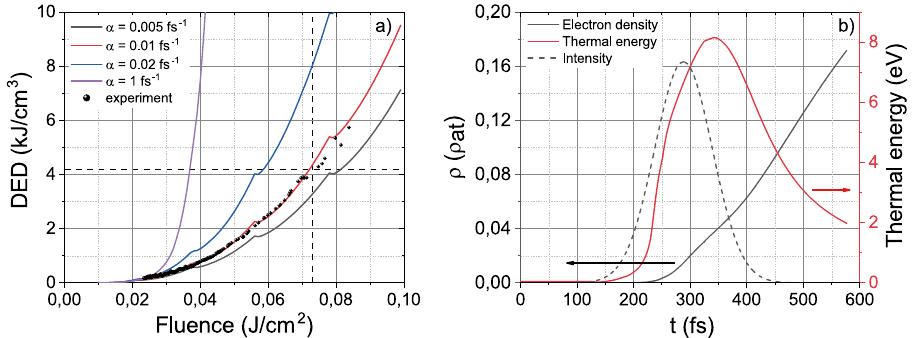
Figure 5. ( a ) Dependence of deposited energy density (DED) for the different probability of impact ionization α on fluence. Black points indicate the experimental values of DED. The horizontal dashed line marks the DED threshold, which is needed for Si crystal lattice melting and the vertical dashed line marks the fluence threshold, which is needed to achieve the DED threshold value. ( b ) Free electron density and mean thermal energy during the laser pulse action. The pulse intensity profile is shown as the dashed line. Pulse fluence corresponds to the threshold value of 0.073 J/cm 2